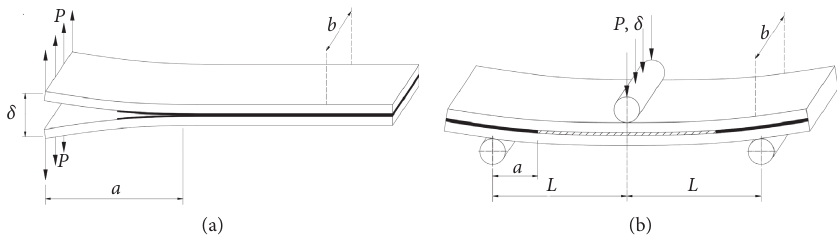
Figure 10: Energy release rate measurement of (a) the double cantilever beam specimen and (b) the end-notched flexure